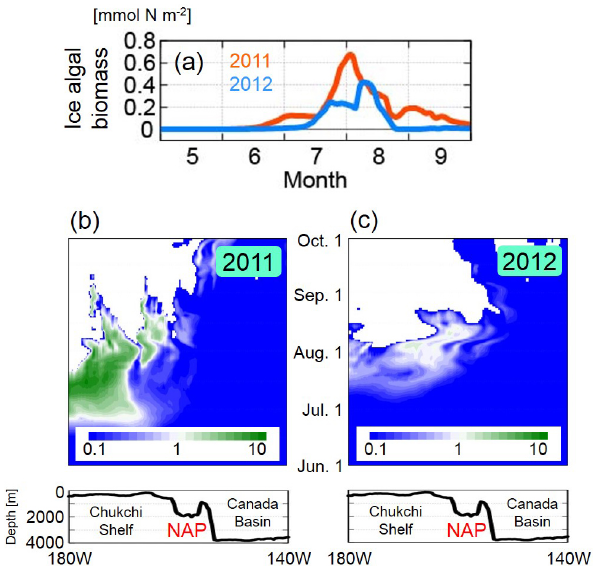
Figure 6. Modeled seasonal transition of ice algal biomass (a) in the NAP region and (b–c) along the 75 ◦ N line (mmolNm − 2 ) . Sea floor depths along the east-west section are also plotted (m). Red line in (a) and Hovmöller diagram in (b) correspond to the 2011 case. Blue line in (a) and the diagram in (c) correspond to the 2012 case. The content of 1mmolNm − 2 in the sea ice column corre- sponds to the concentration of 50mmolNm − 3 when the skeletal layer thickness is set to 2cm.